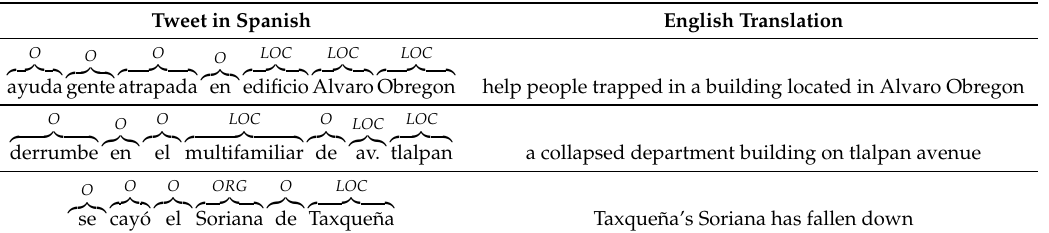
Table 5. Examples of tweets with their corresponding named entity tags. Tweet in Spanish English Translation